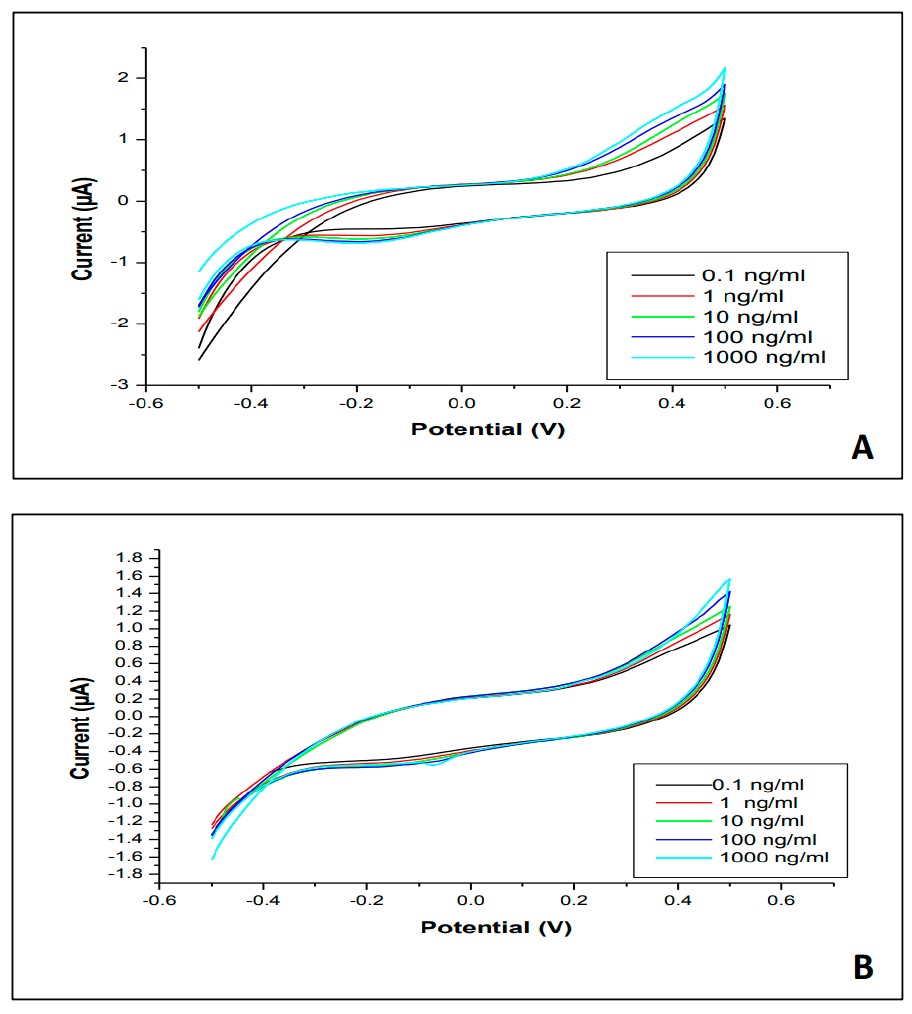
Figure 3. Cyclic voltammograms of screen-printed electrodes without immobilized aptamers in HBB solutions with different concentrations of HgCl 2 ( A ) and PbCl 2 salts ( B ).